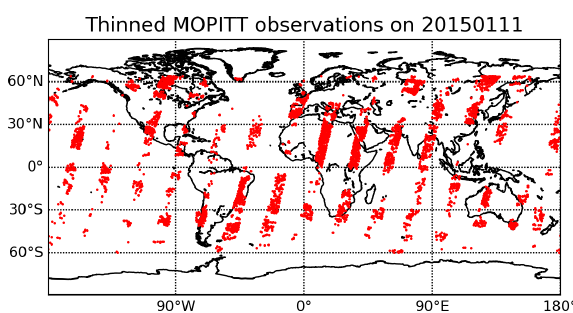
Figure 4. An example of the distribution of MOPITT satellite observations. Thinned MOPITT orbits on 11 January 2015 at 00:00:00UTC are